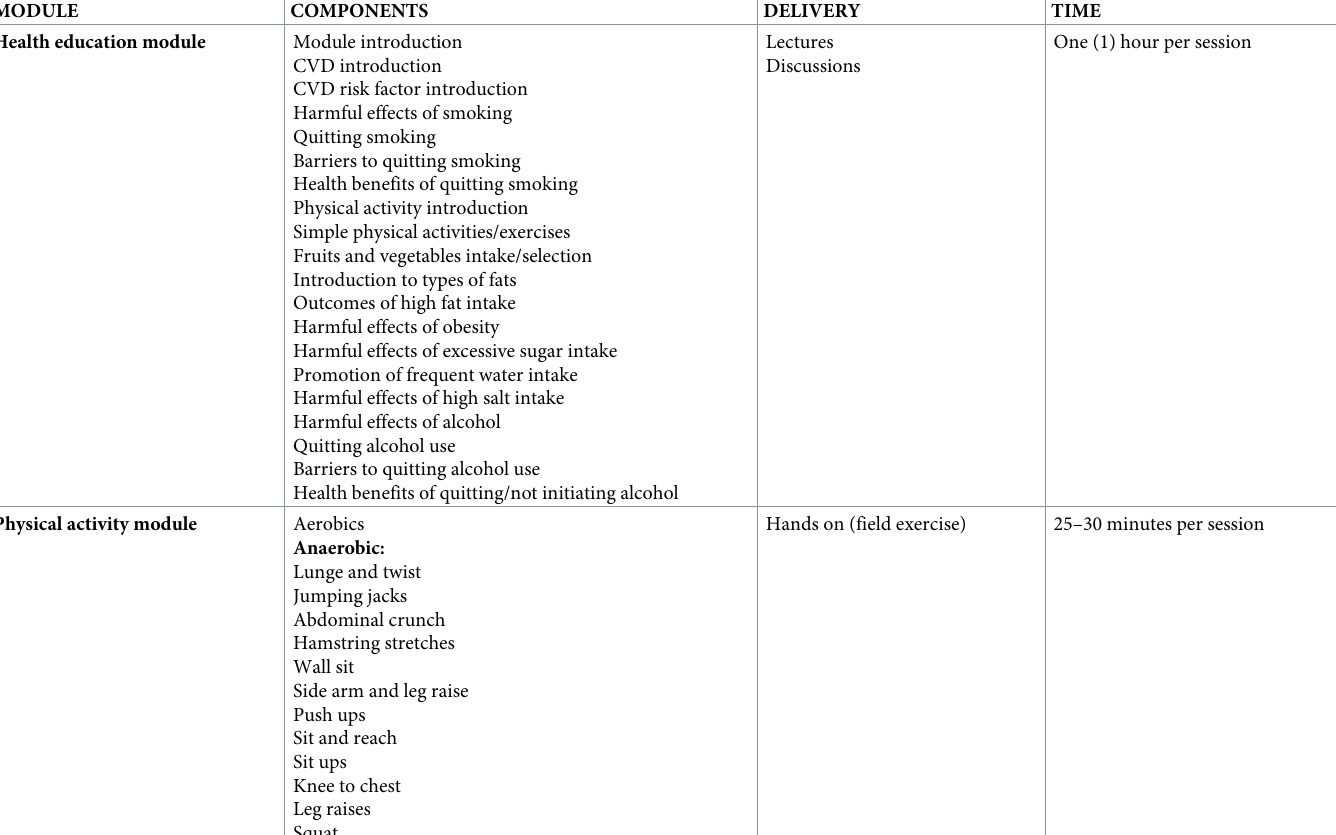
Table 1. Summary of intervention